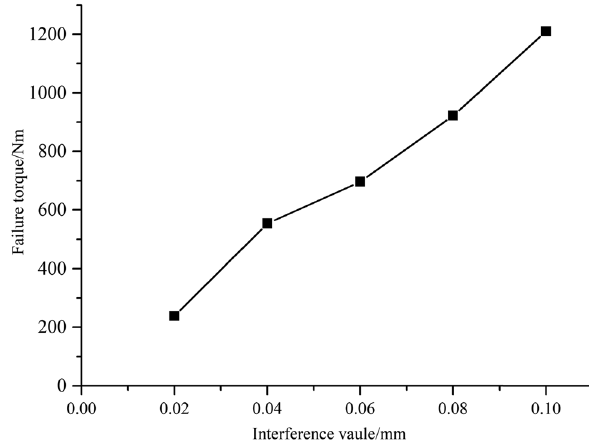
Figure 13: Relationship between failure torque and interference value.